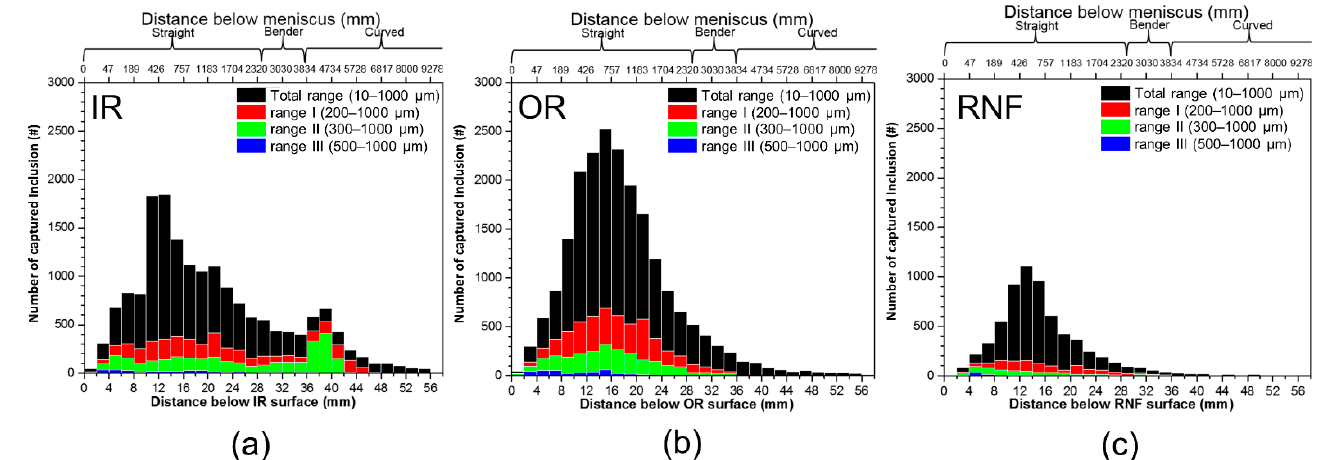
Figure 10. Histograms of modeled inclusion capture locations on ( a ) the IR shell, ( b ) the OR shell, and ( c ) the right NF shell.